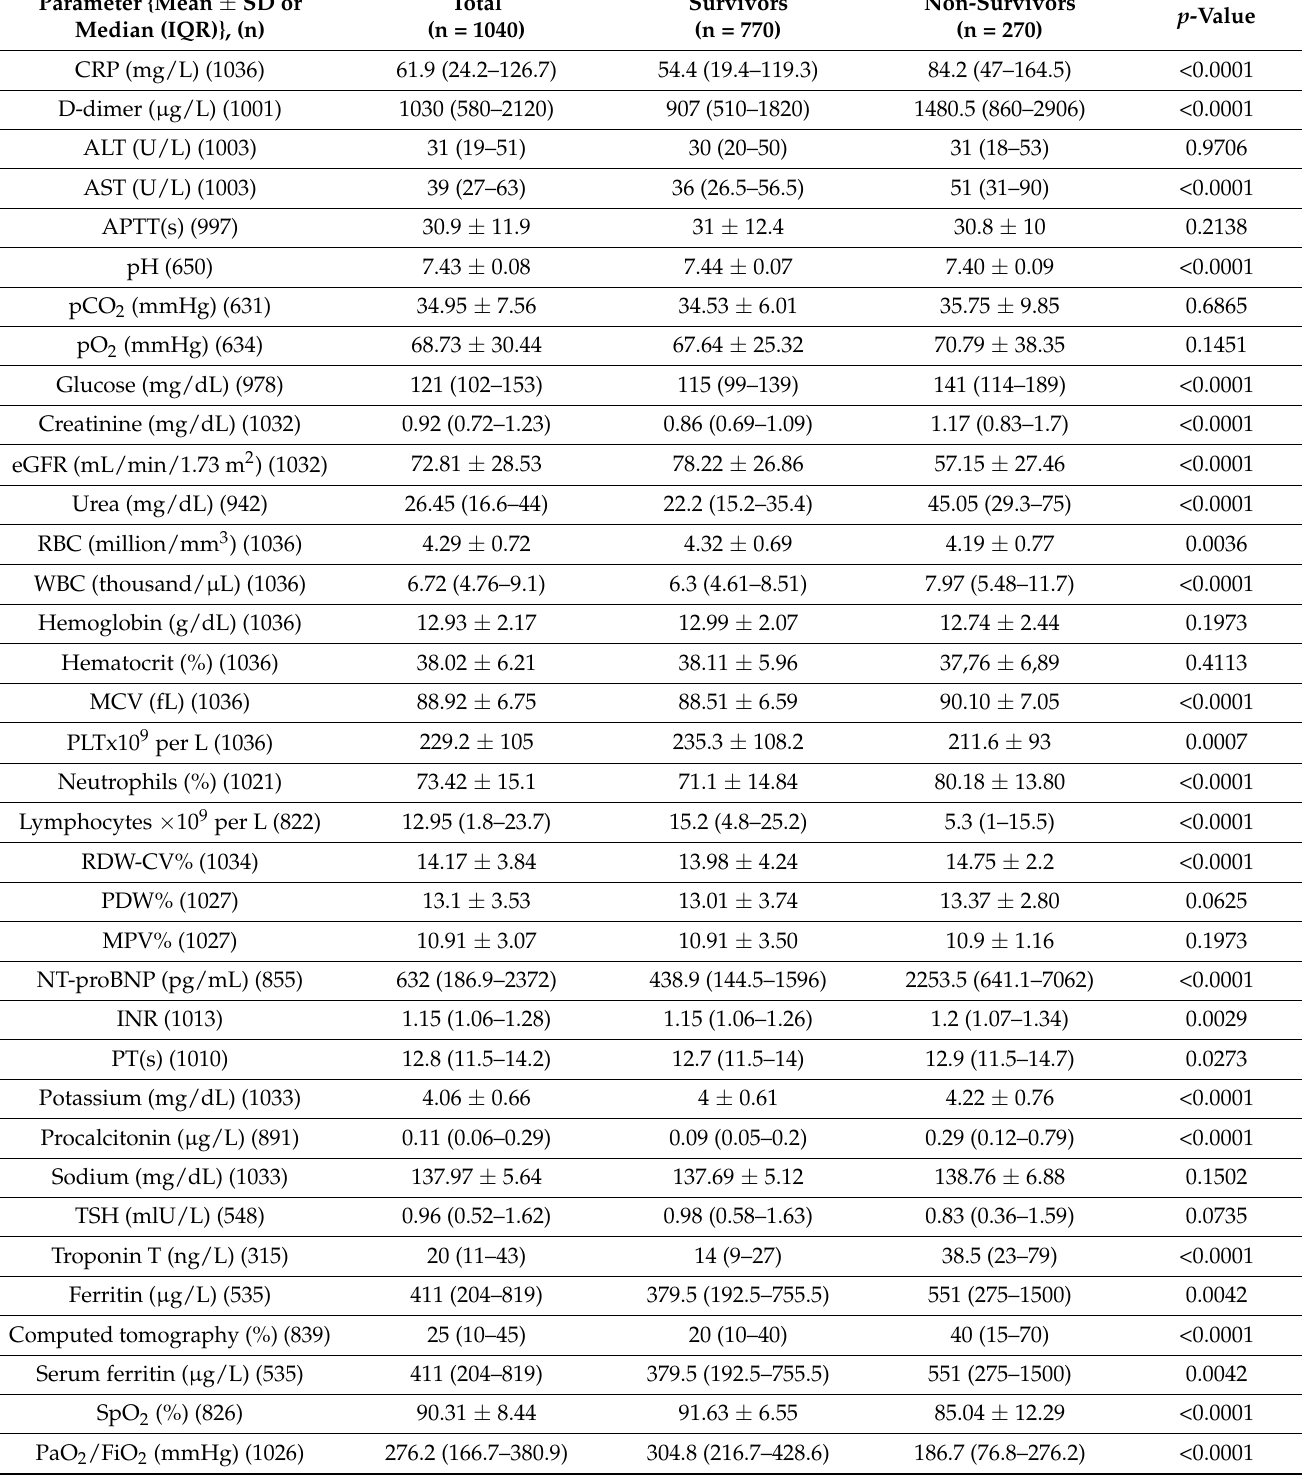
Table 2. Biochemical characteristics of both